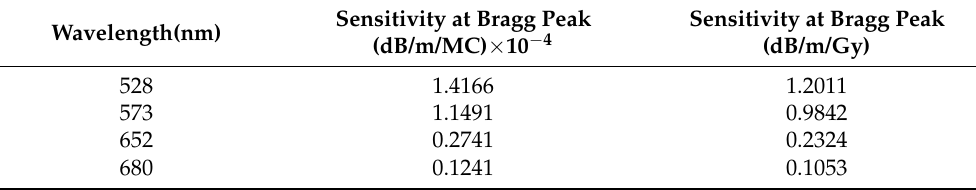
Table 3. Sensitivity of INO fibre at Bragg wavelength for fibre irradiated with proton